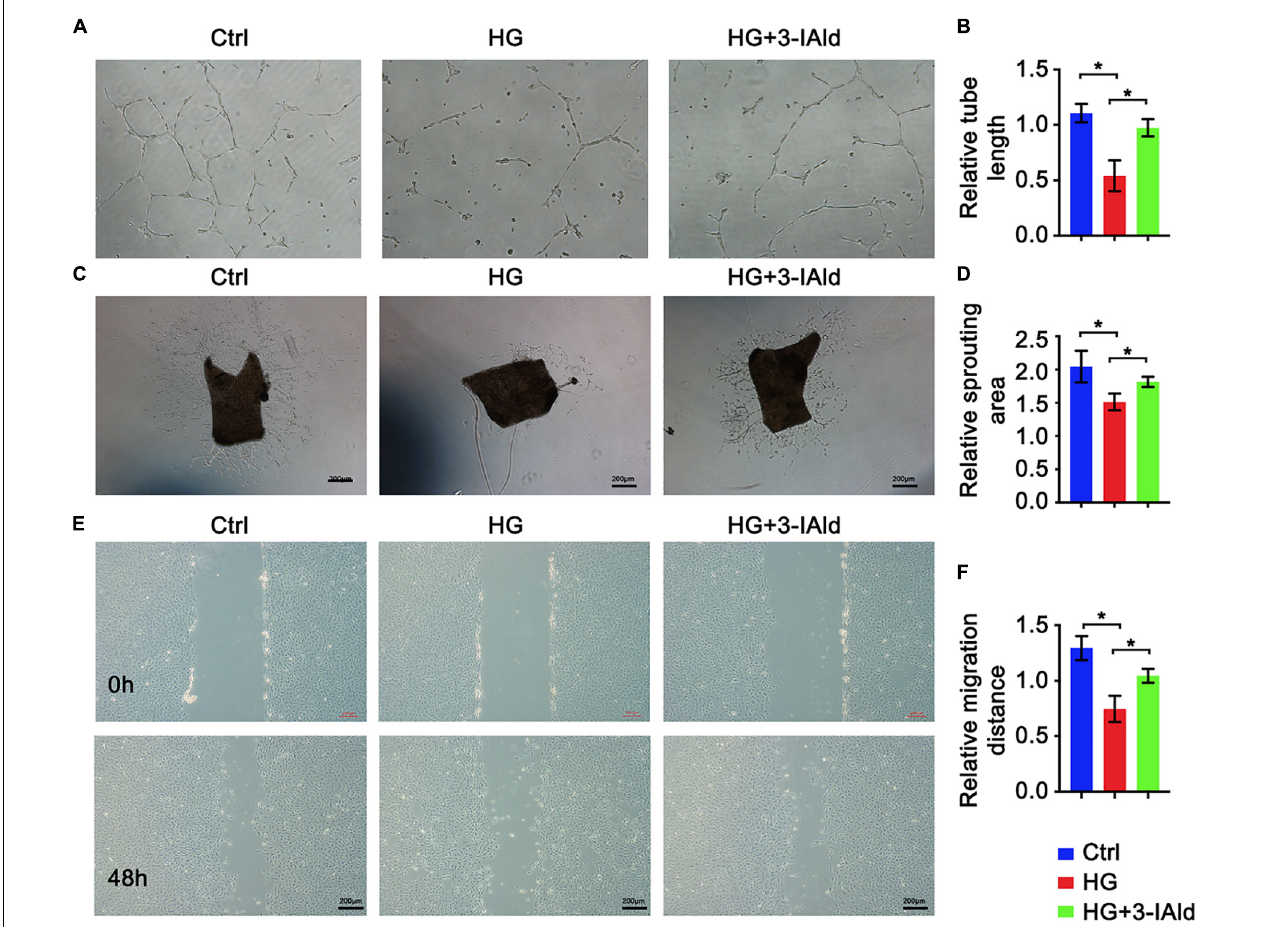
FIGURE 2 | 3-IAld protects ECs from HG-induced angiogenic dysfunction. (A) Original micrograph of tube formation in HUVECs in the control, HG and HG + 3-IAId groups; scale bar: 100 µ m. (B) Quantitative analysis of relative tube length; n = 6 for each group. (C) Original micrograph of sprouts grown from aortic rings in the control, HG and HG + 3-IAId groups; scale bar: 200 µ m. (D) Quantitative analysis of the relative sprouting area; n = 6 for each group. (E) Original micrographs of the wound healing assay; scale bar: 200 µ m. (F) Quantitative analysis of wound healing assay in control, HG and HG + 3-IAId groups in HUVECs; n = 6 for each group. Data are presented as the mean ± SEM. * P <